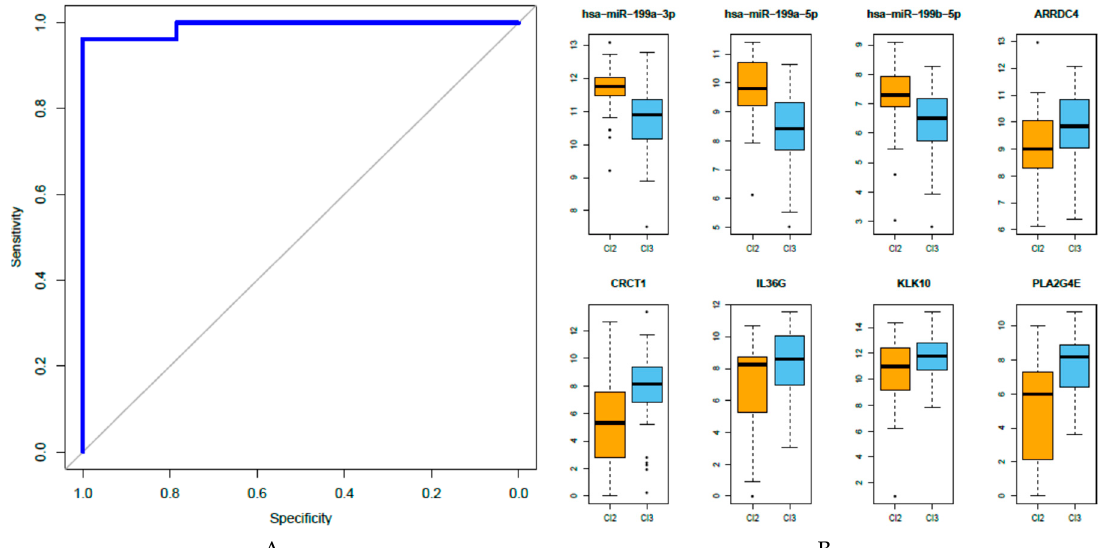
Figure 5. ( A ) Performance of the eight miRNA – gene expression predictive model: The performance of our signature (blue line) in predicting PFS after cetuximab ‐ CT treatment was tested in terms of sensitivity and specificity by ROC analysis (AUC = 0.992); ( B ) Analysis of the expression of the eight features entered in the miRNA-gene integrated signature in HNSCC TCGA data set: The tumors were stratified based on our six HNSCC subtypes [34] and miRNA and gene expression data were retrieved for the Cl2-mesenchymal (30 samples) and Cl3-hypoxia (59 samples) subtypes. A significant upregulation of hsa-miR-199a-3p, hsa-miR-199a-5p, and hsa-miR-199b-5p in Cl2 ( p = 7.25E-05, p = 3.8E-06, p = 0.0019, respectively) and of ARRDC4, CRCT1, IL36G, KLK10, and PLA2G4E in Cl3 ( p = 0.021, p = 4.66E-05, p = 0.00199, p = 0.0135, p = 2.42E-06, respectively) was observed.